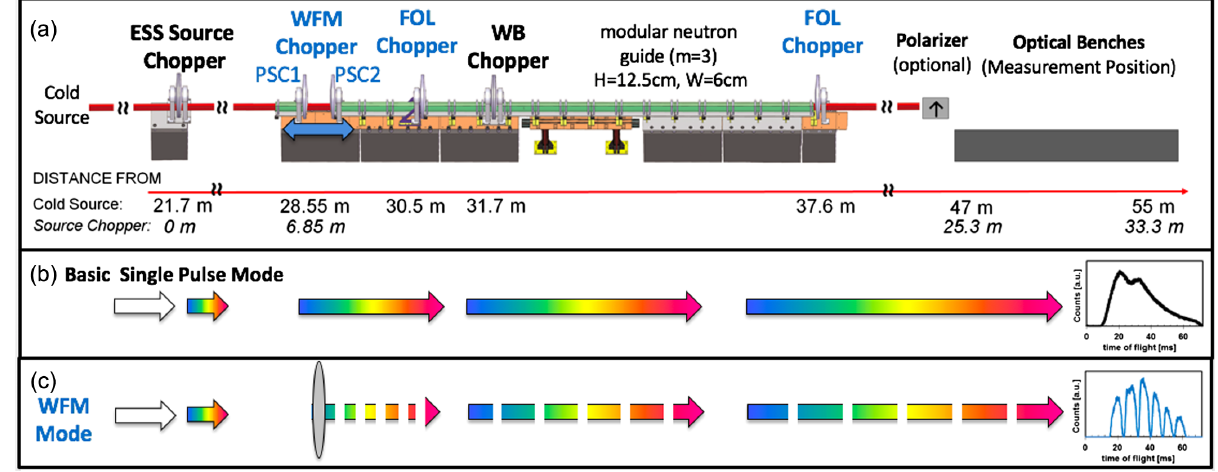
FIG. 5. Layout of the ESS test beam line V20. (a) choppers. The Source chopper system consists of the ESS source mimicking chopper (also capable of producing longer or shorter pulses than the one of the future ESS) and a wavelength-band (WB) chopper. (b) Illustration of the basic single-pulse mode, where the measurement position defines the wavelength (energy) resolution and a continuous spectrum is recorded at the detector. (c) Illustration of the six-fold wavelength frame multiplication (WFM) mode, where the spectrum is divided into subframes that are separated in TOF, but overlap in wavelength. Figure and description from Ref. [29]. For the herein presented results, the basic single-pulse mode was utilized where the WB chopper was fixed to restrict the wavelength band and the source chopper opening was varied in order to adjust the incident neutron flux. The WFM chopper system was parked in the open position.